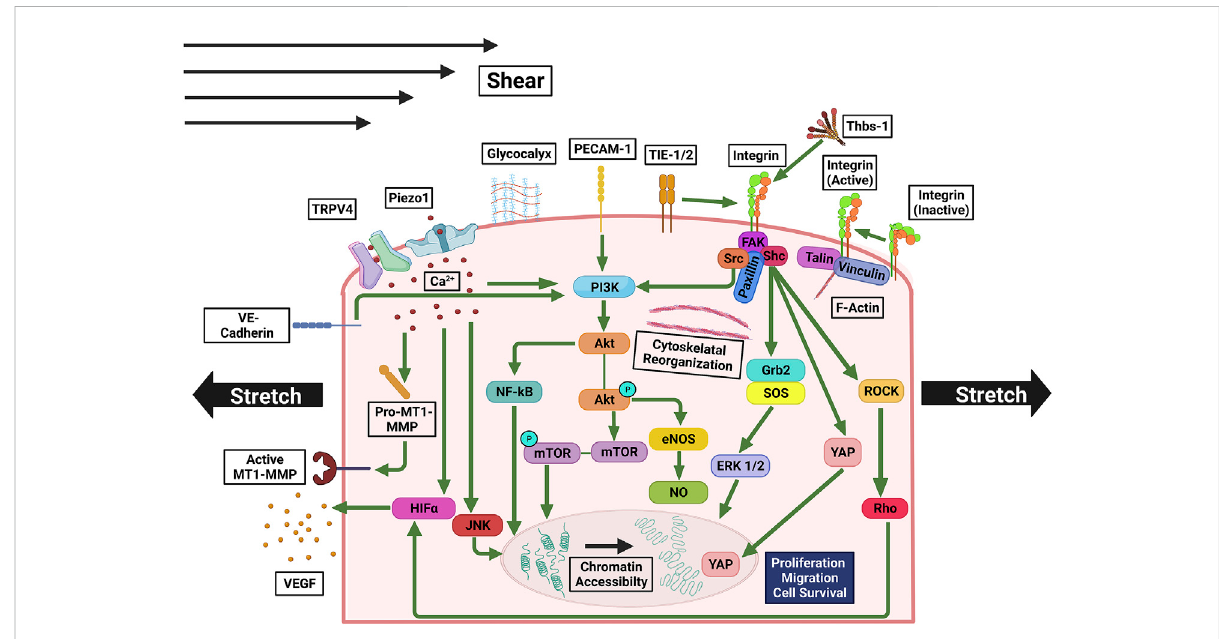
FIGURE 4 Mechanosensitivepathwaysinvolvedinsignalingtriggered bystretchingand/orshearstress.Ca 2+ in fl uxthroughPiezo1 andTRPV4upregulates MT1-MMP, PI3K, JNK, promoting cell growth and proliferation, and HIF α , upregulating VEGF expression. PI3K is also upregulated by PECAM-1, integrin,andVE-Cadherin,whichareactivatedbymechanicalstress,andinturn,activateAkt.Akt ’ sdownstreampathwaysactivateNF- κ BandmTOR, which facilitate cell growth and proliferation, as well as eNOS and NO, which enhance cell survival. Activated integrin, to which a macromolecular complex of FAK, Shc, Src, and Paxillin is bound, interactswith TIE-1/2. Rho and ROCK are activated by FAK and/or Src, upregulating in HIF α . Shc upregulates Grb2, SOS, and FRK 1/2, promoting cell proliferation and growth. Under shear stress and stretch YAP is translocated to the